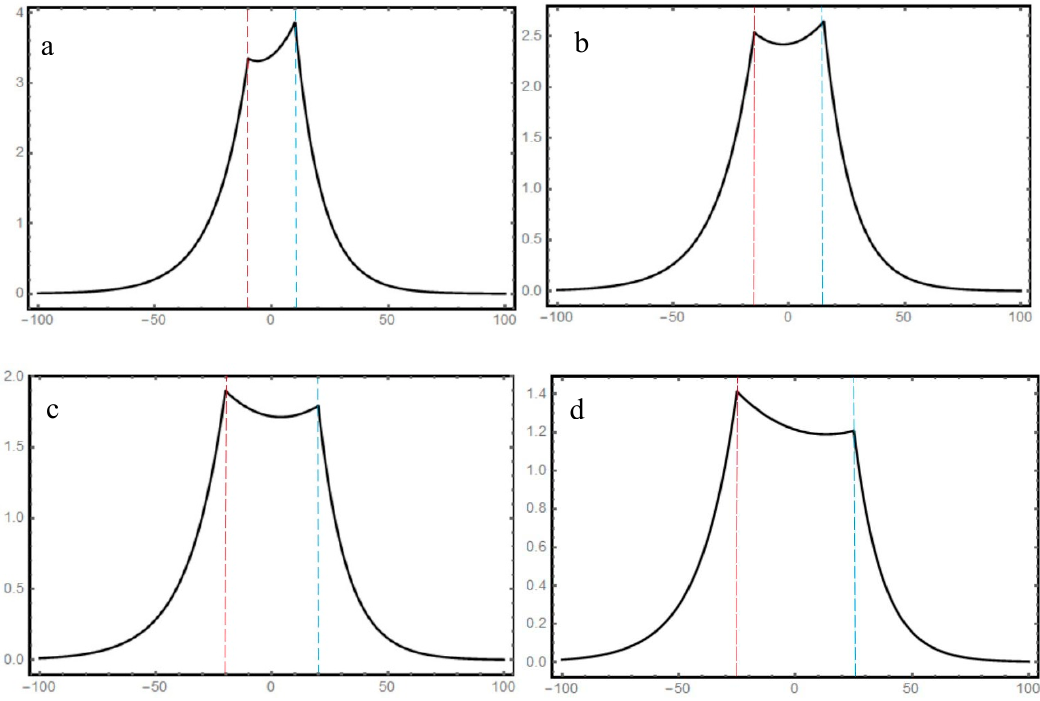
Figure 4. SPPs’ distribution of the dimensionless H y component in the photoresist layer with different equivalent dielectric layer thicknesses. ( a – d ) correspond to the thicknesses of 30, 40, 50, and 60 nm, respectively.